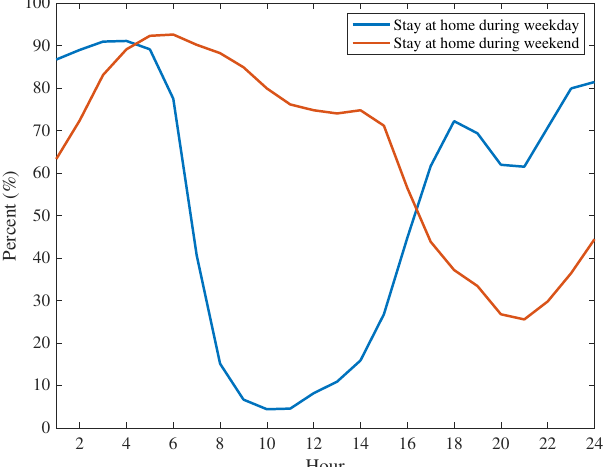
Figure A1. Hours when participants stay at home during weekdays and